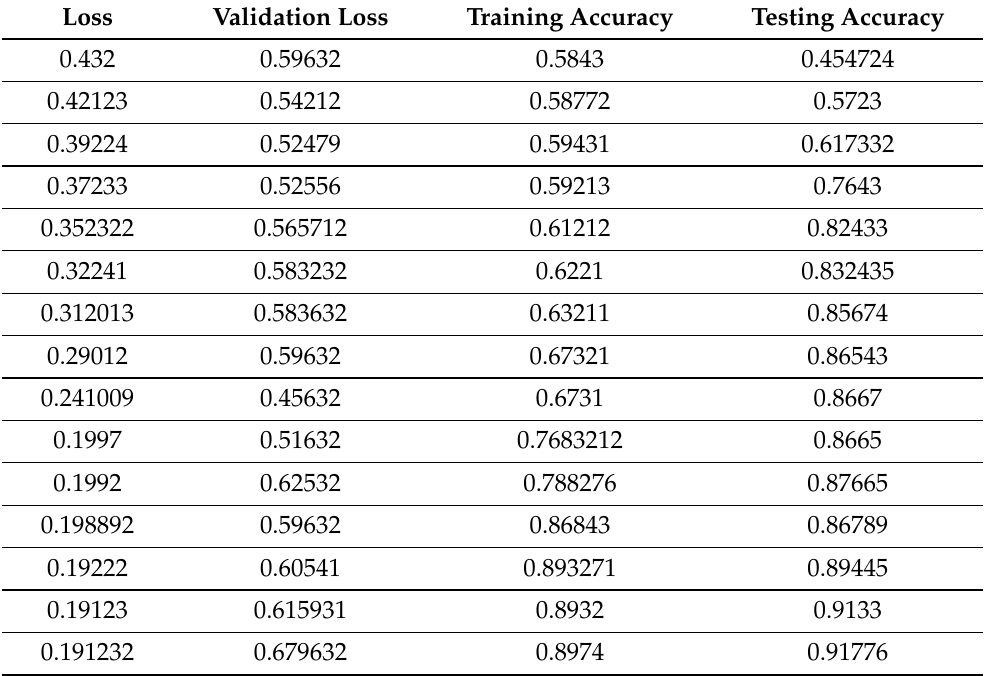
Table 1. Parameters of the Resnet with VGG experimental analysis.